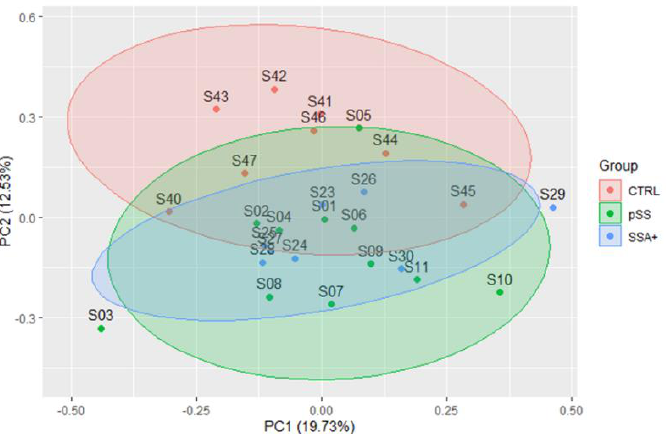
Figure 1. PCA scores plot of the first two principal components. Different groups of subjects are shown by colors: healthy controls in red, pSS patients in green, and SSA+ patients in blue. The ellipse around each group represents the 95% confidence interval, using Hotelling’s T 2 statistics.